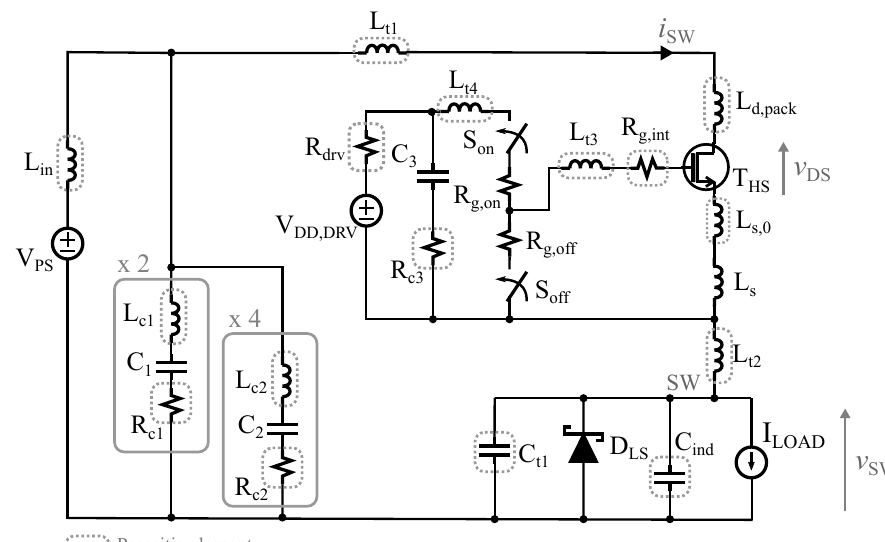
Figure 7. Power stage of the designed step-down Buck converter, including the active ( T HS , D LS ) and the passive ( C 1 , C 2 ) devices. Parasitics due to printed circuit board (PCB) traces, packages and non-idealities of the passive components are enclosed in dashed